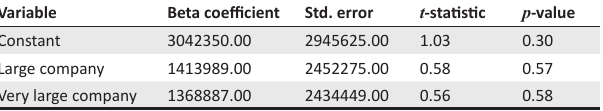
TABLE 5: Regression analysis – fixed pay and company size .